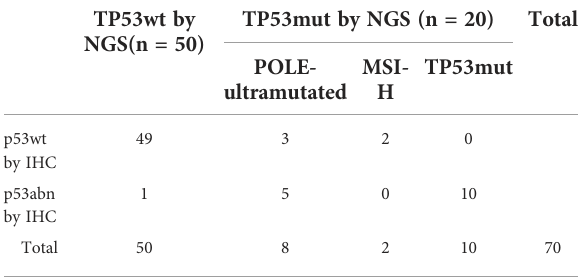
using the 11-gene NGS panel, indicating the high heterogeneity in molecular subtypes of G3 EECs, which has been reported in